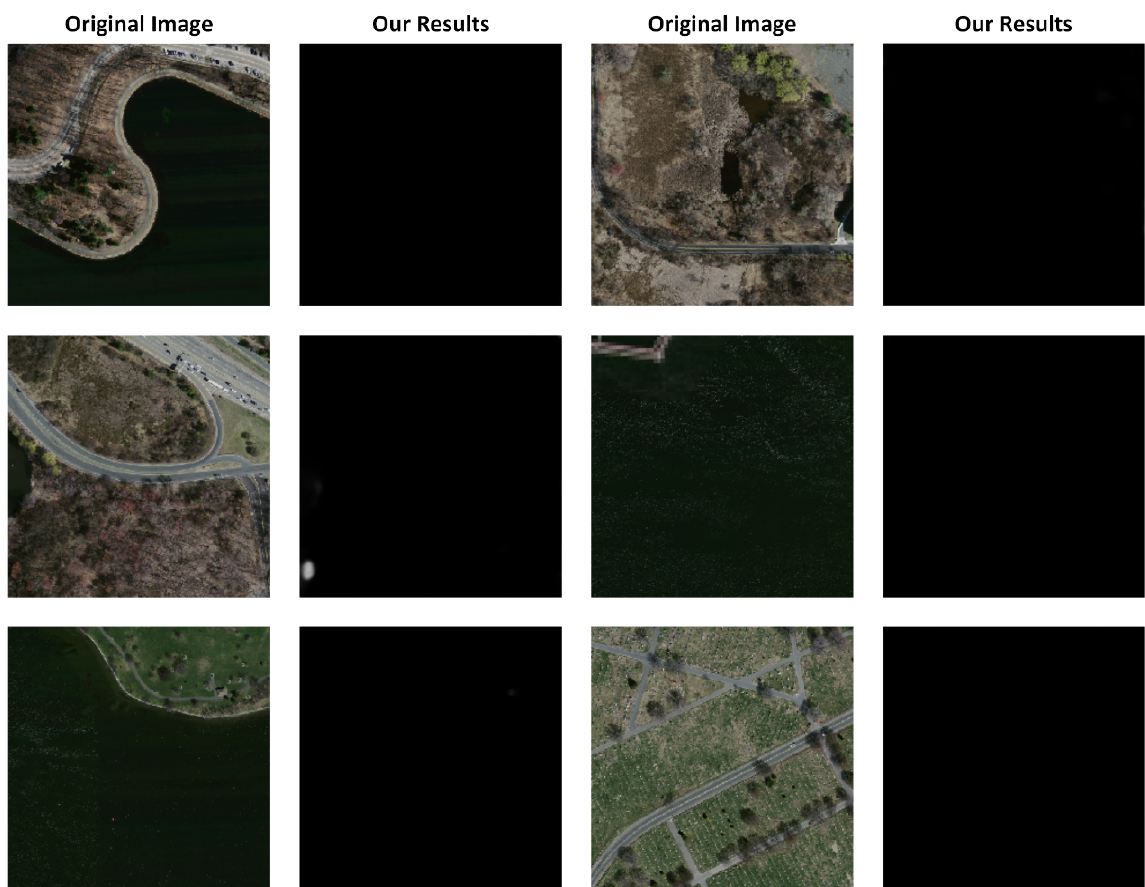
Figure 13. The extraction result exhibitions of images without buildings in the Massachusetts Building dataset.